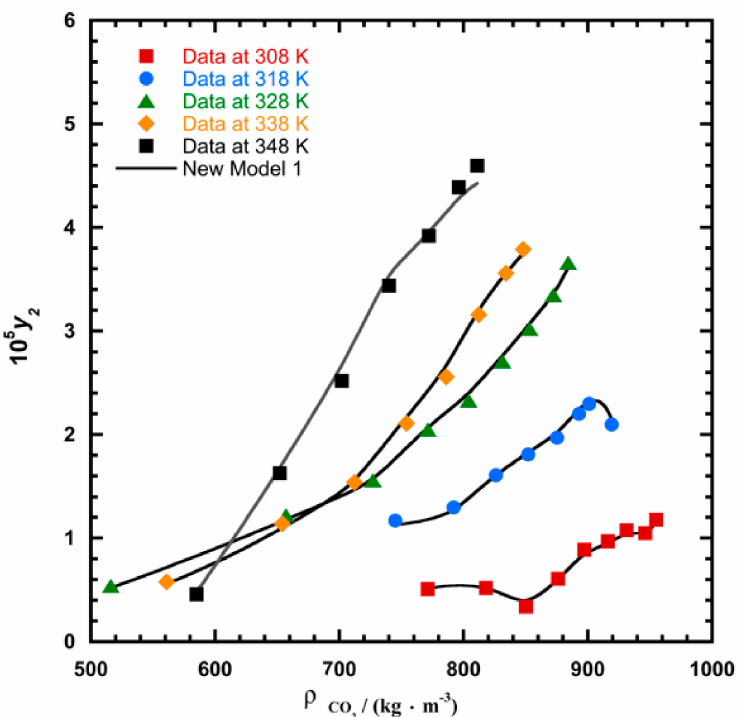
Figure 2. Plot of mole fraction ( y 2 ) as a function of density ρ /(kg.m − 3 ) for 1-amino-2,3-dimethyl-